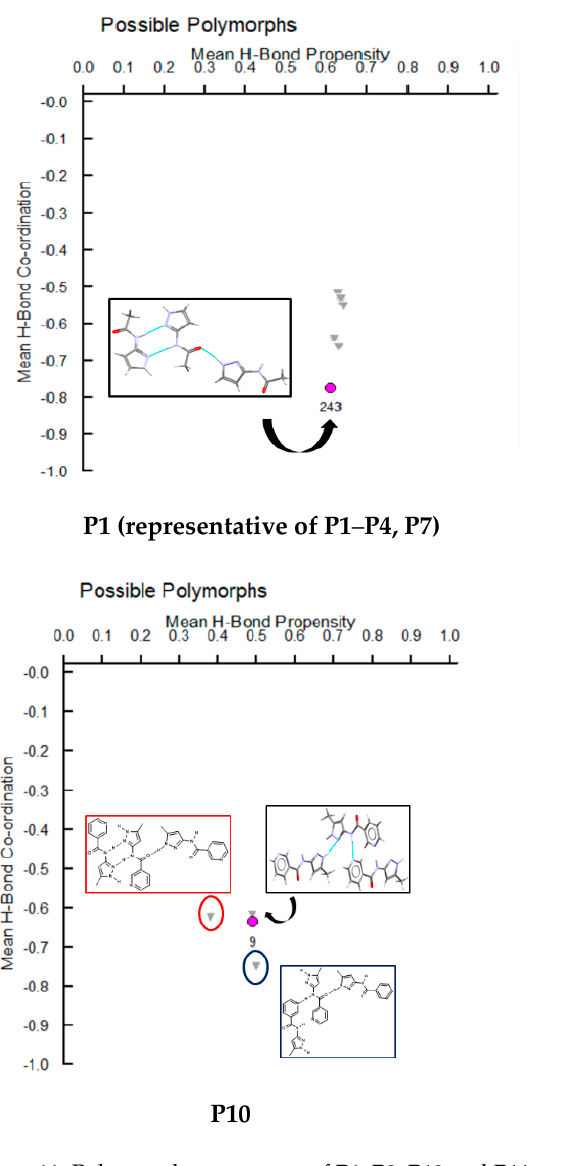
Figure 11. Polymorph assessment of P1, P8, P10 and P11 molecules showing the experimental structure and more stable hypothetical structure.